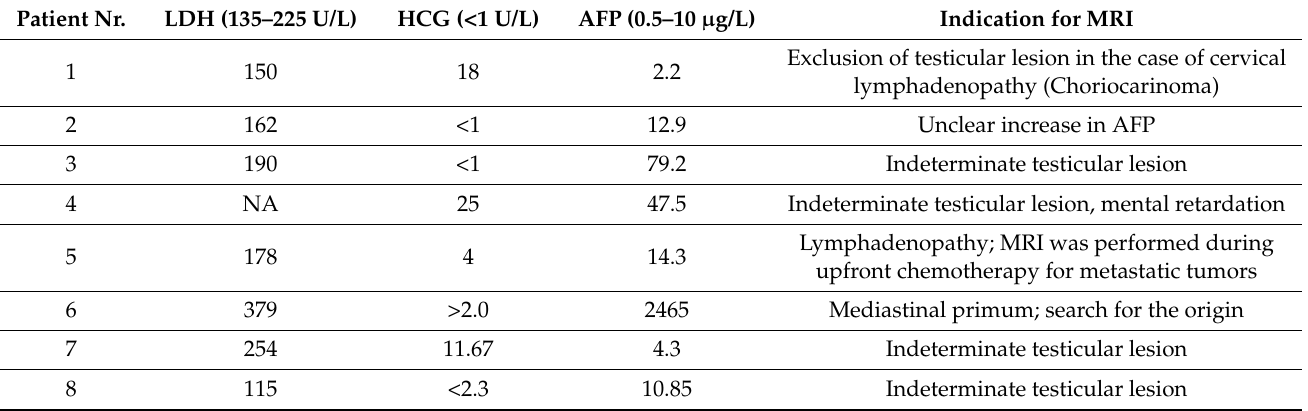
Table 3. Positive tumor marker patients included in the study ( n = 8; MRI: magnetic resonance imag- ing; AFP: alpha-fetoprotein; LDH: lactate dehydrogenase; HCG: human chorionic gonadotrophin). Patient Nr.